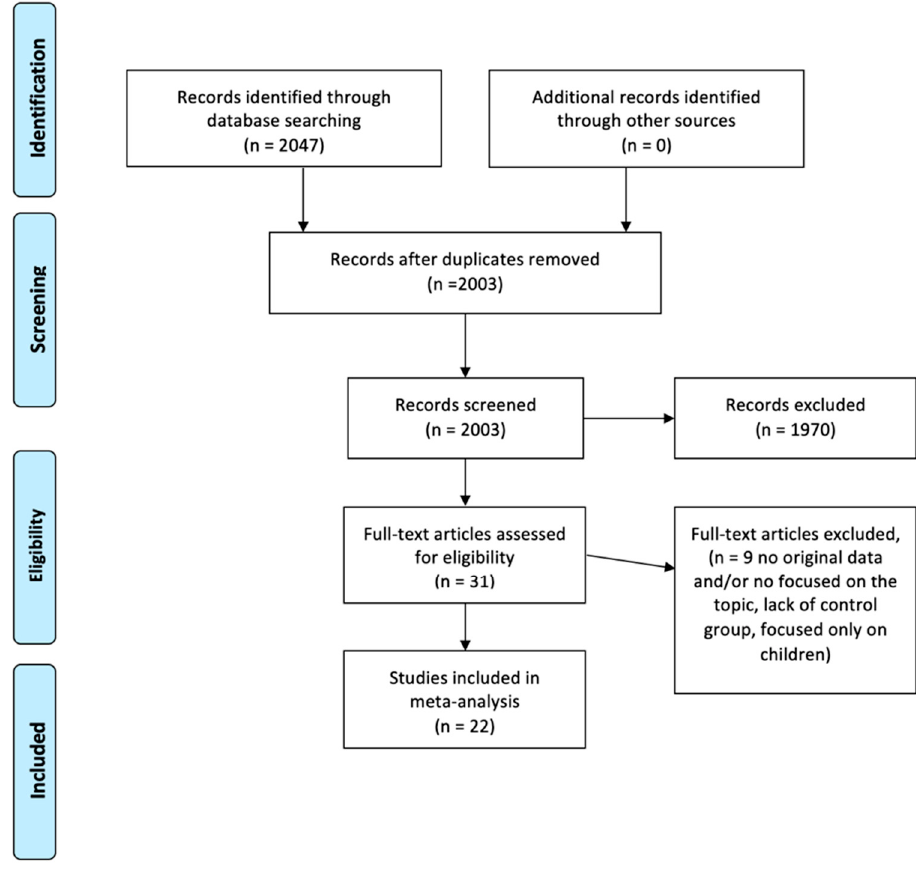
Figure 1. PRISMA flowchart of screened and included articles. Figure 1. PRISMA fl owchart of screened and included articles. Table 1. General characteristics of the studies reported in 22 articles selected for